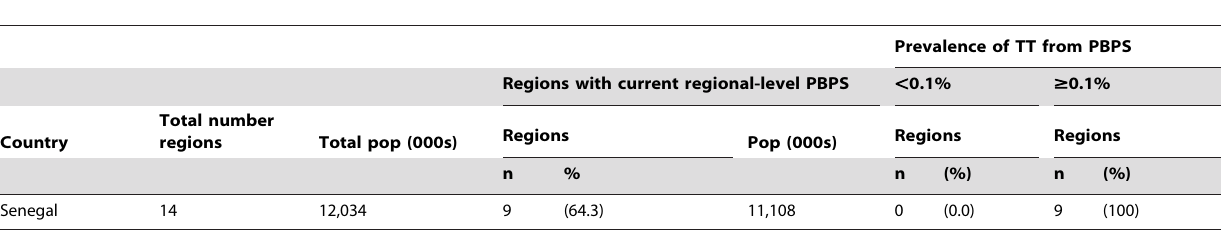
Table 6. Availability of current region level trachomatous trichiasis (TT) data from population based prevalence surveys (PBPS) in Africa in adults aged greater than 15